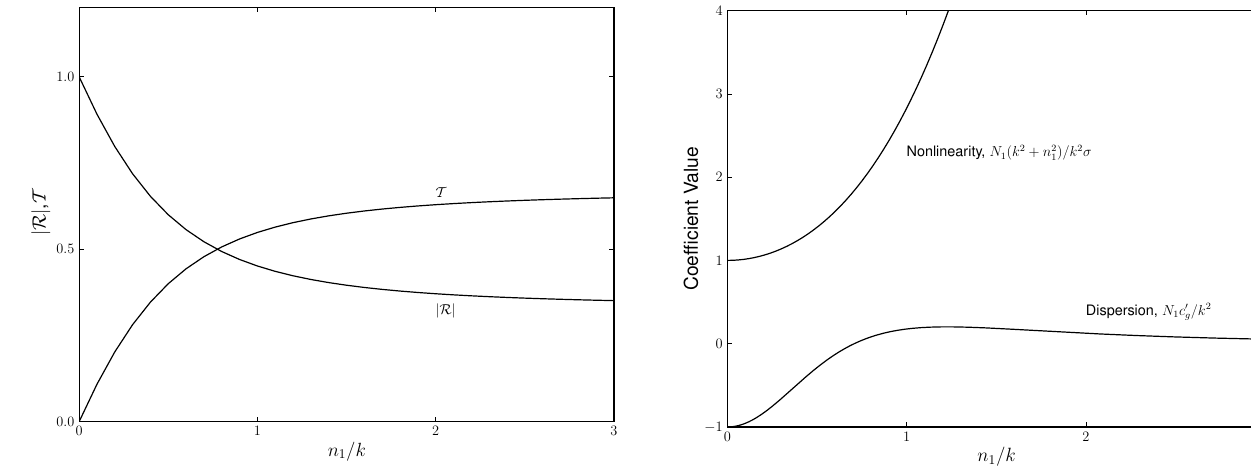
Figure 1. Transmission coefficient and absolute value of the re- T | as n flection coefficient | 1 /k increases. R